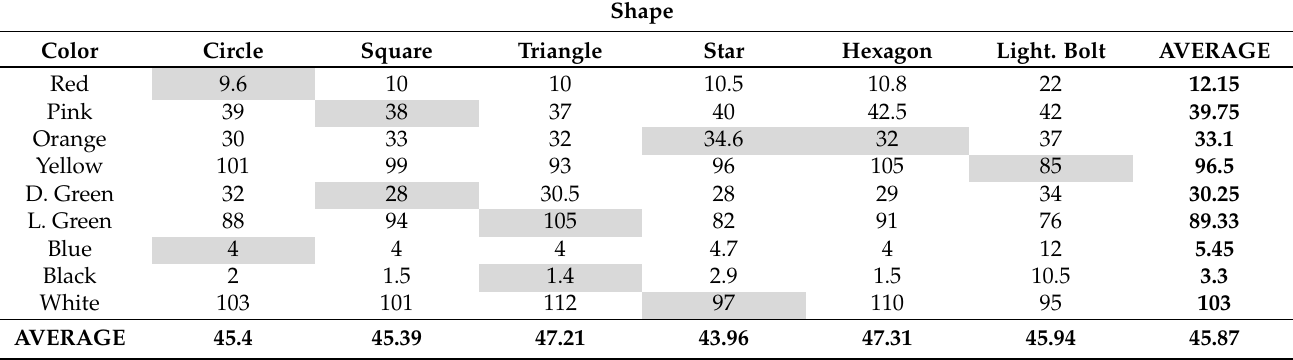
Table 1. Measurements of luminance (cd/m 2 ) taken from the physical targets and the digitalized targets appearing on the touch screen for the target discrimination task to ensure that luminance levels on the computer screen and on the physical targets were comparable. The specific targets assigned to individual monkeys (Figure 2) are shaded in gray. Distractors are unshaded. Bold text indicates the average luminance for each color and shape; luminance is fairly consistent across shapes but varies widely across